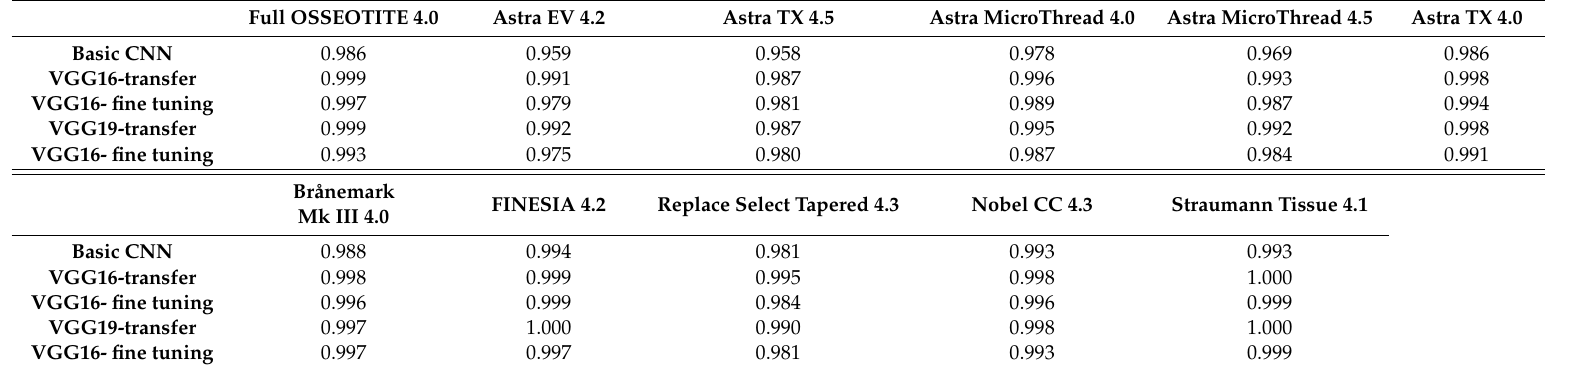
Table 4. Dental implant classification performance by the area under the recover operating characteristic curve